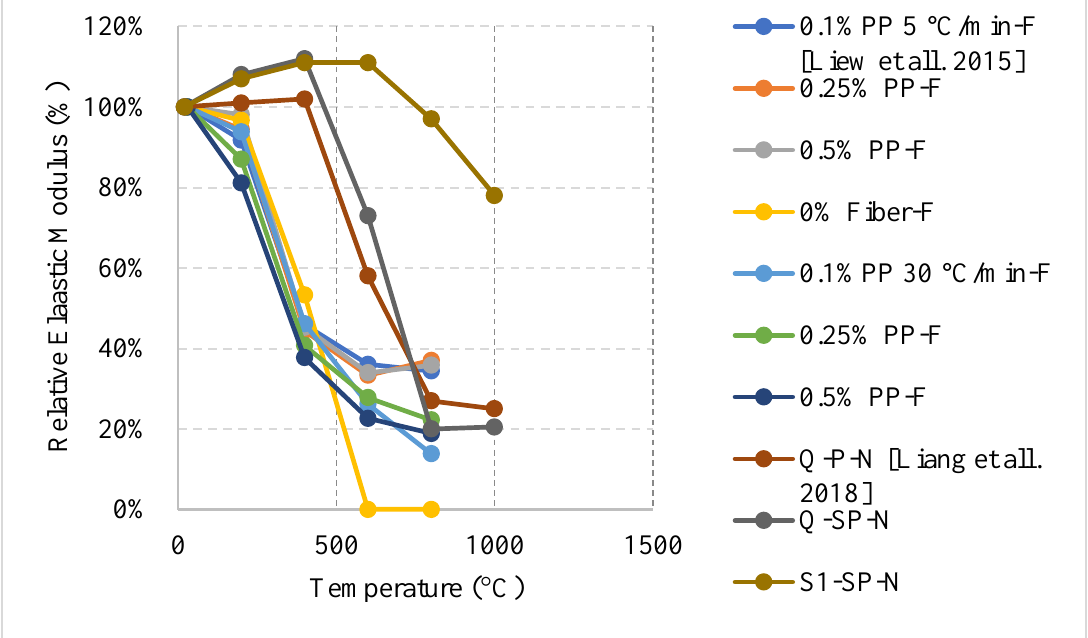
Figure 42. Relative Elastic modulus of different naturally/furnace cooled UHPC mixes. N = Natural cooling, F = Furnace cooling, S = steel fibers, P = PP fibers SP = Steel and PP fibers, Q = Quartz sand, S1 = Steel slag [47,93].